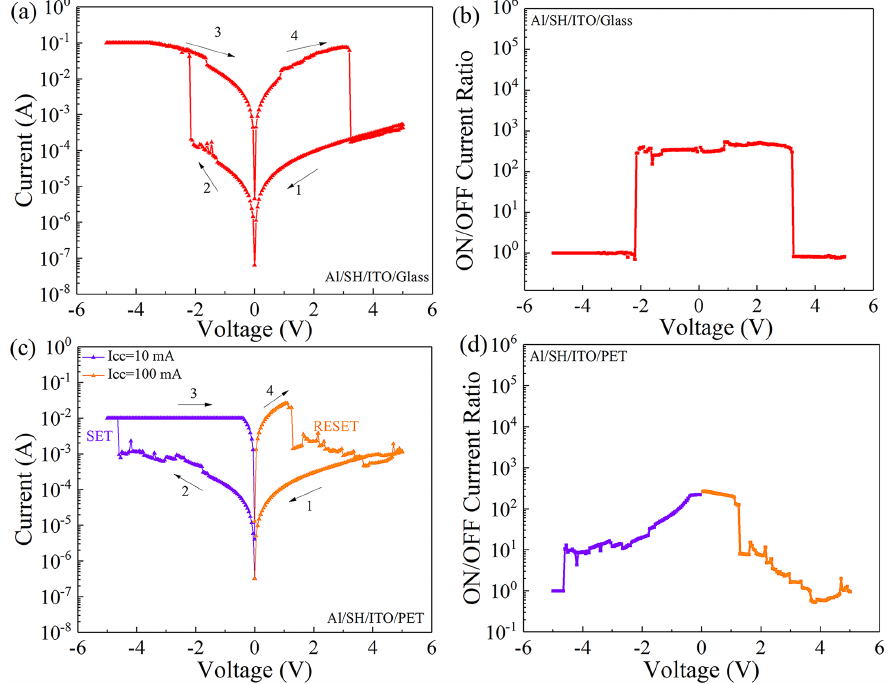
Figure 3. Al/SH/ITO/glass device: ( a ) I-V characteristic curve and ( b ) ON/OFF current ratio. Al/SH/ITO/PET device: ( c ) I-V characteristic curve and ( d ) ON/OFF current ratio.